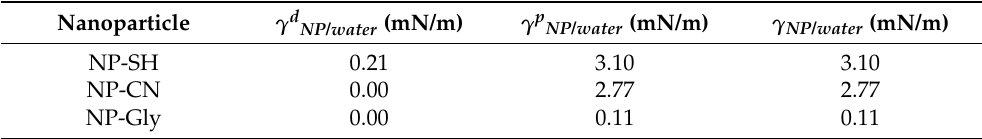
Table 1. Interfacial energy and its disperse γ d ticles with water, bearing different surface functional groups. The data for NP-CN and NP-SH were taken from reference